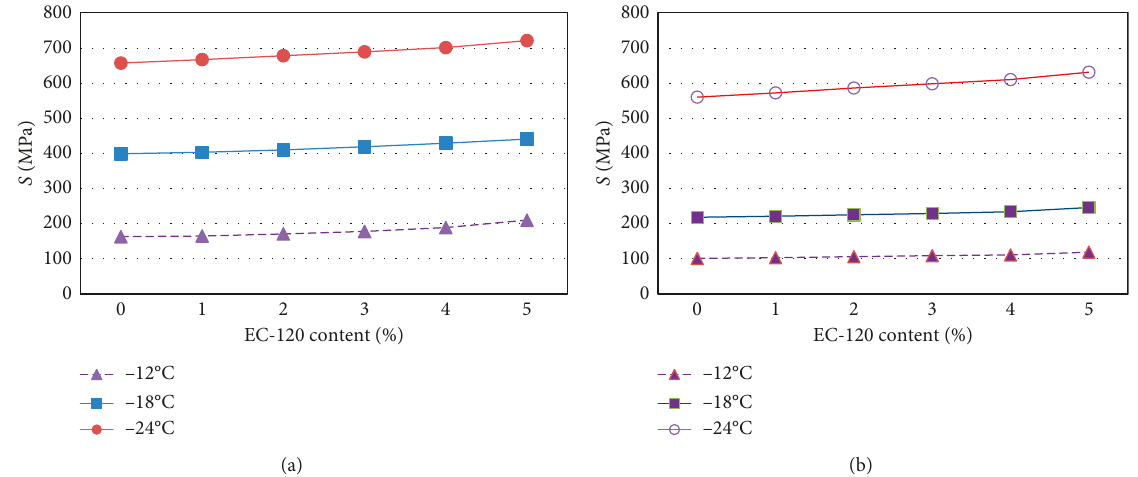
Figure 1: Relationship between G /sin δ and EC-120 dosage of WMAs. (a) Warm-mixed matrix asphalt A-70. (b) Warm-mixed SBS I-D. ∗